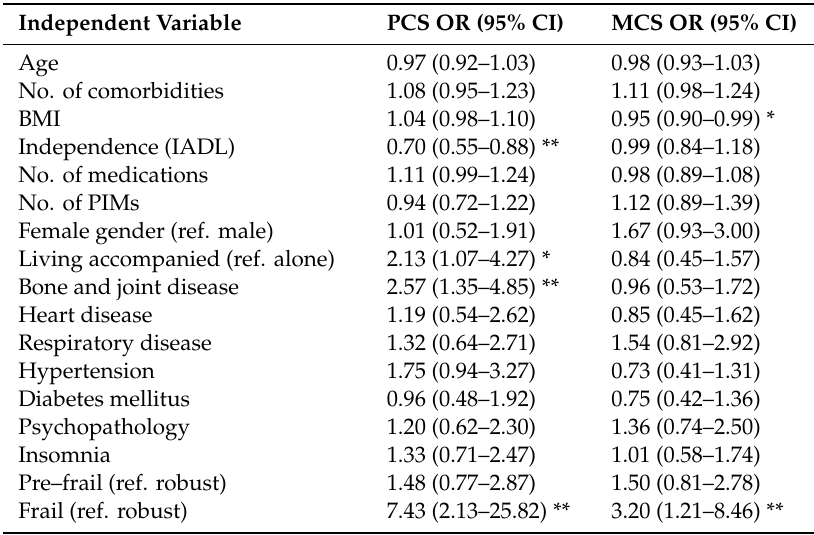
Table 4. Factors related to HRQoL. Multinomial Logistic Regression for Low HRQoL (with respect to Very High HRQoL) for physical and mental health components